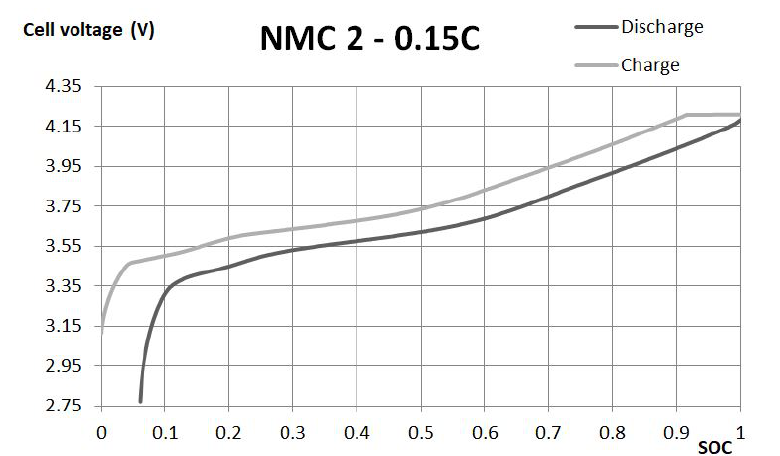
Figure 2. Charge and discharge voltages at 0.15 C in dependence of SOC for the NMC2